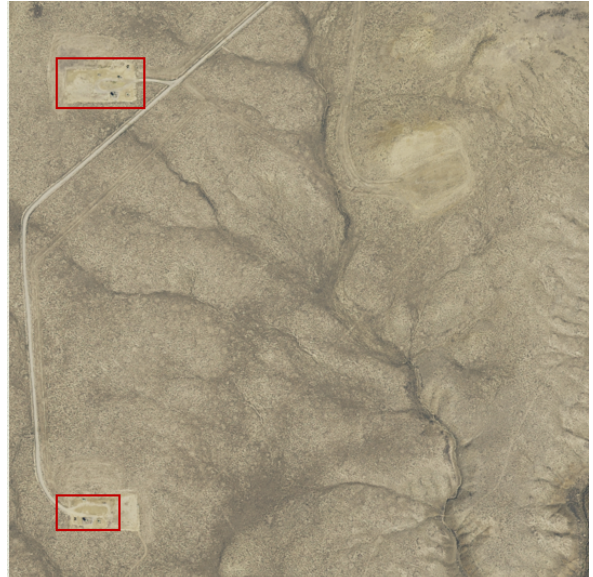
Figure 2. Input image with multiple oil pads used for training the